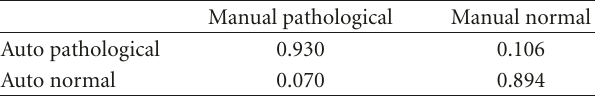
Table 9: Mean confusion matrix for the 10 training sets (Two correlations case).